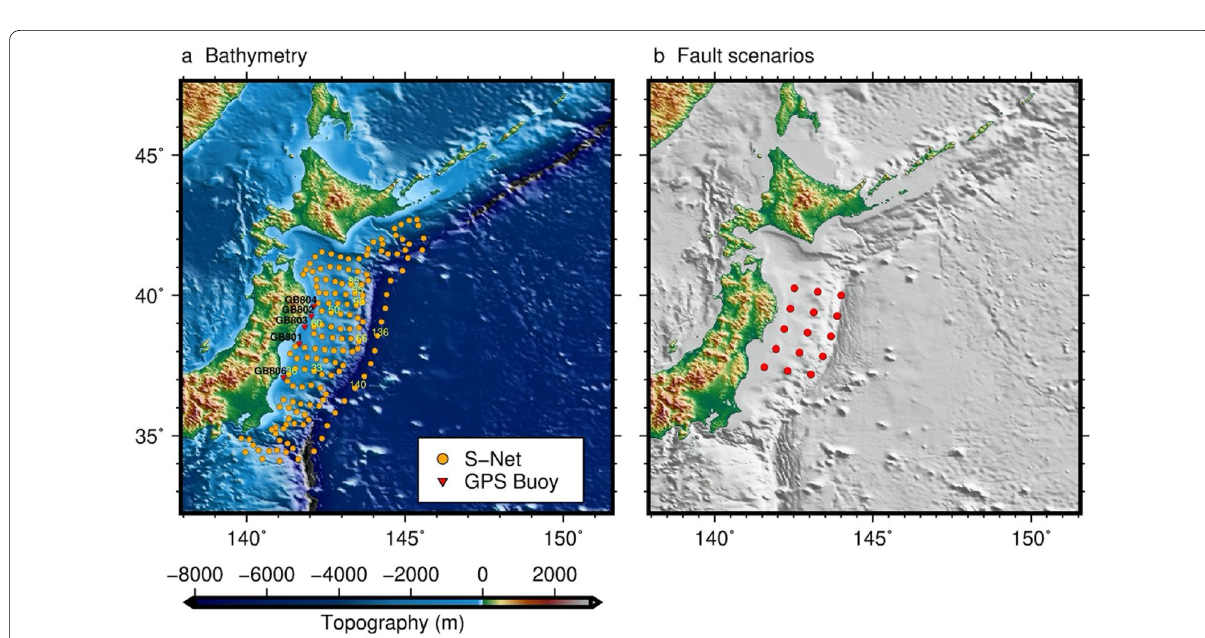
Fig. 7 a Bathymetry data and the locations of S-Net and GPS buoys stations; b top-center of the fault scenarios to develop the